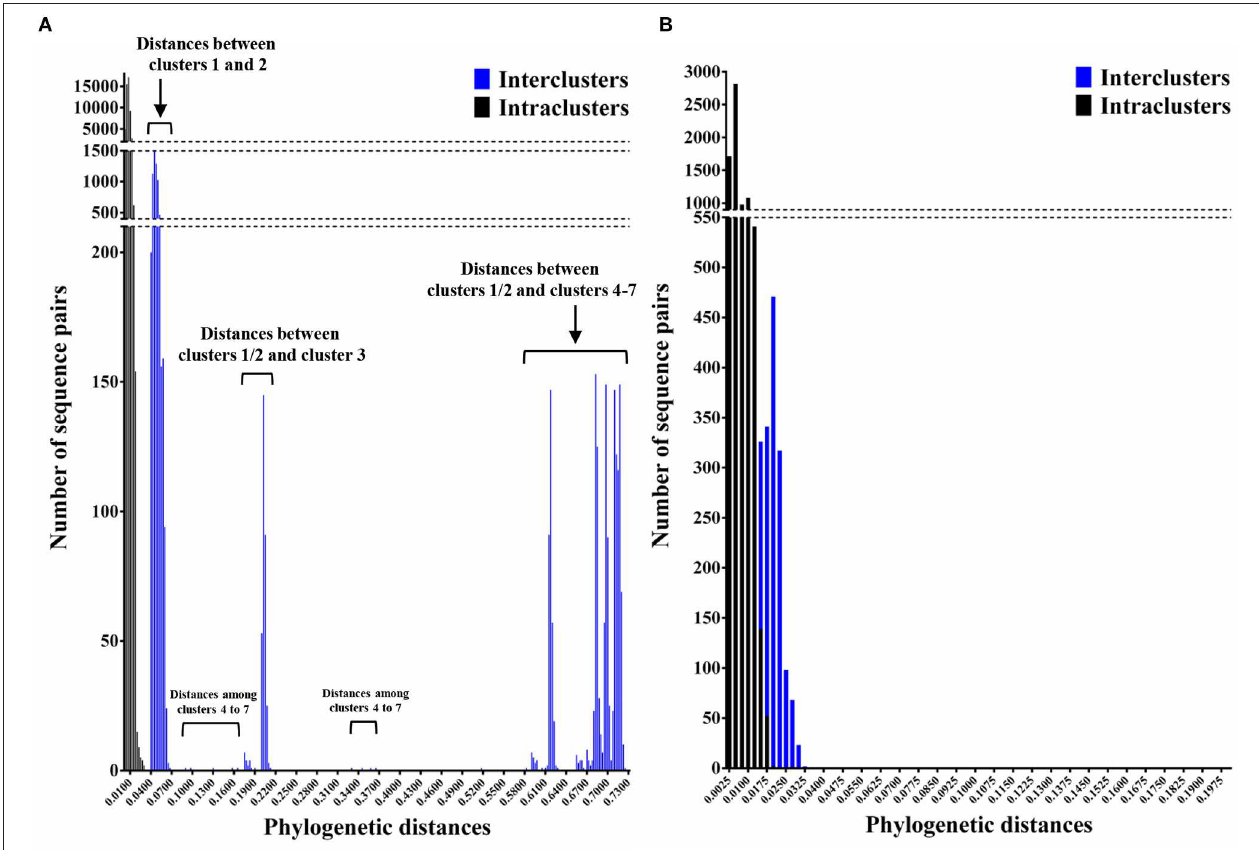
FIGURE 3 | Phylogenetic distances between the nucleotide sequences of GII.17 strains in the full-length VP1 and RdRp regions. (A) Distribution of intra-genotype phylogenetic distances in the VP1 region of the GII.17 strains; (B) Distribution of intra-genotype phylogenetic distances in the RdRp region of the GII.P17 strains. The y-axis shows the number of sequence pairs corresponding to each distance while the x-axis represents phylogenetic distances.